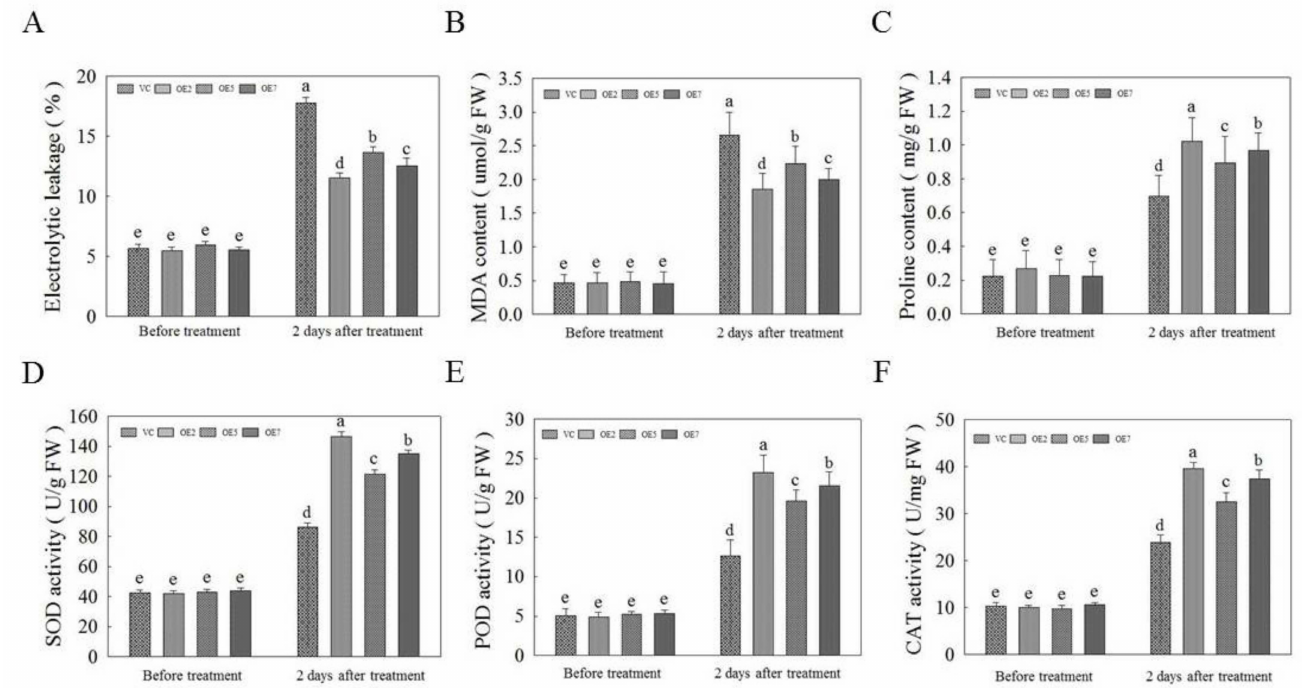
Figure 9. Antioxidant and osmotic indices of vector control (VC) and overexpression (OE) Arabidopsis under normal and stress conditions. ( A ) Electrolytic leakage. ( B ) Malondialdehyde (MDA) content. ( C ) Proline content. ( D ) Superoxide dismutase (SOD) activity. ( E ) Peroxidase (POD) activity. ( F ) Catalase (CAT) activity. Different letters represent significant difgerences ( p < 0.05).